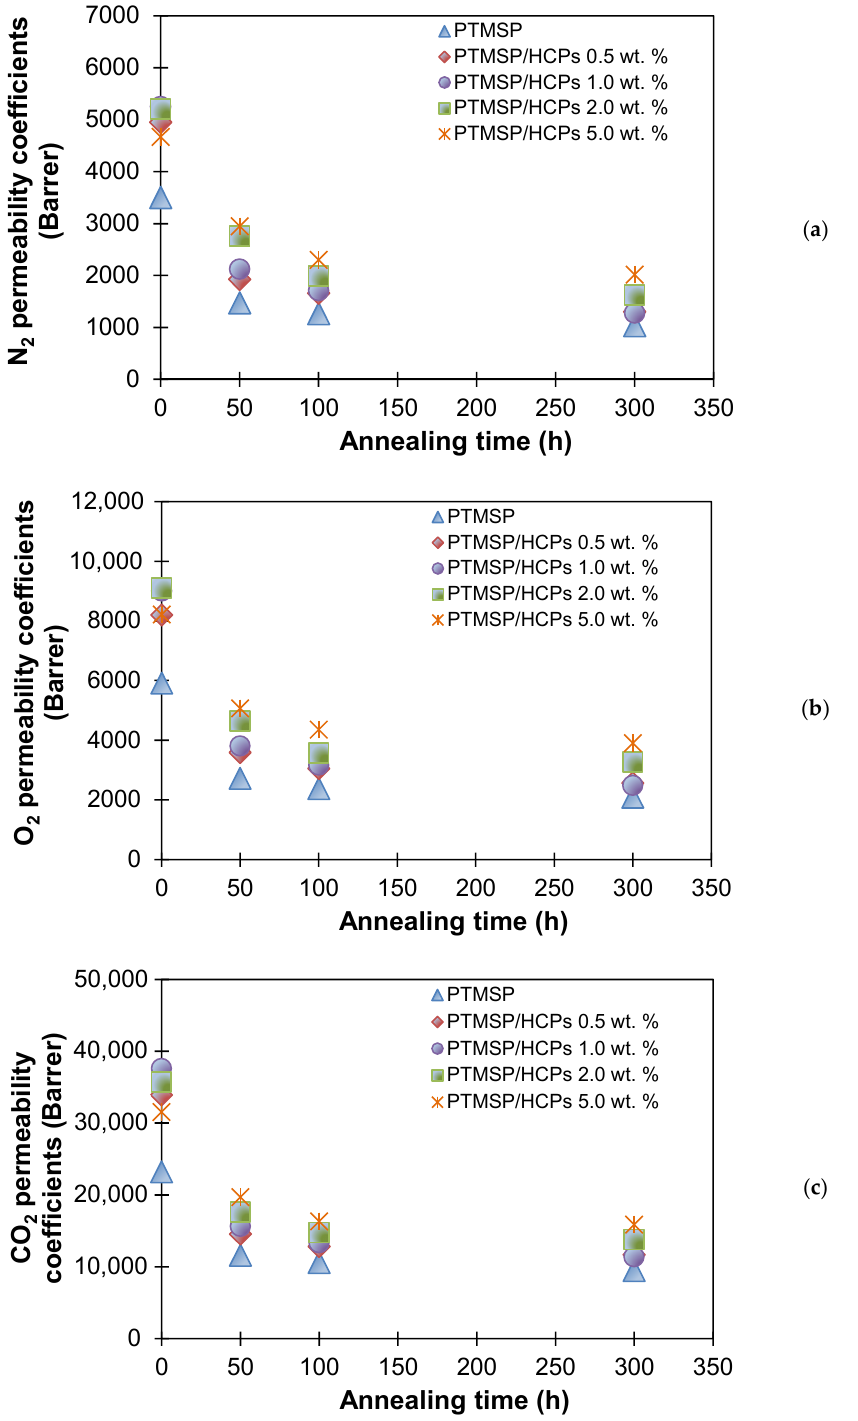
Figure 5. N 2 ( a ), O 2 ( b ), and CO 2 ( c ) permeability coefficients for PTMSP and PTMSP/HCPS membranes containing 0.5, 1.0, 2.0, and 5.0 wt % of HCPS plotted against annealing time at 100 °C.